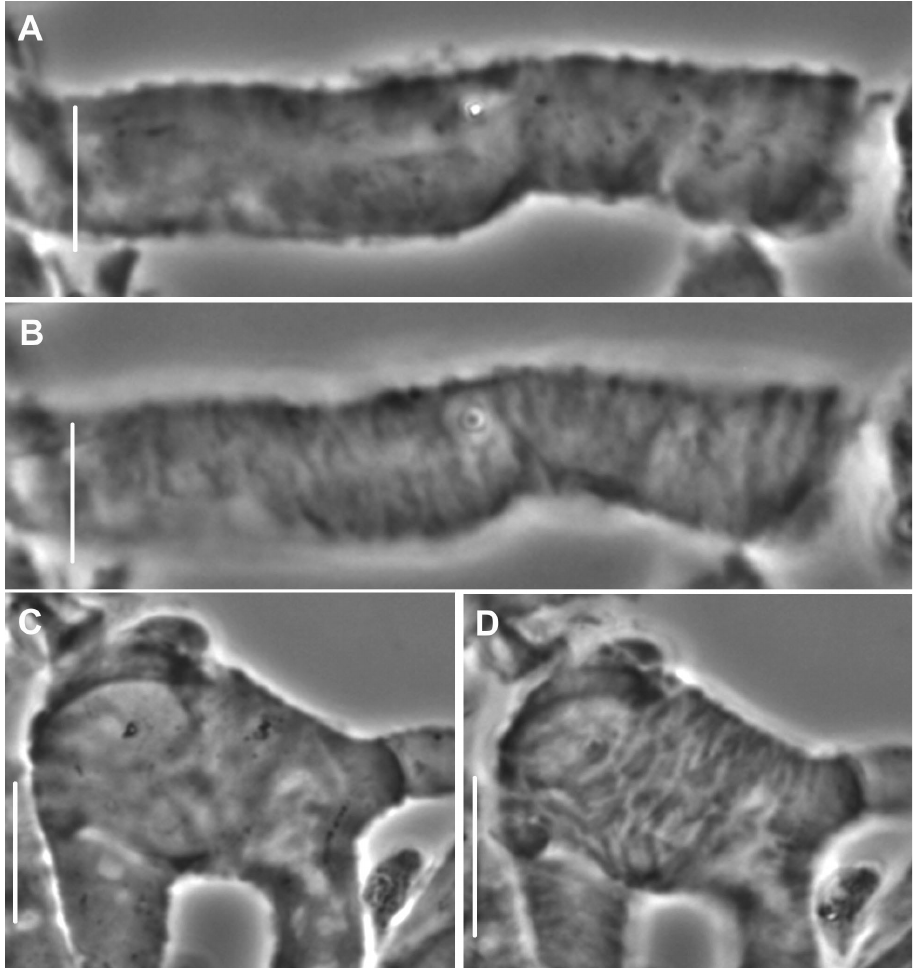
Figure 88. Mycetinis yunnanensis . Pileipellis hyphae. A, C Hyphae seen in profile; note ornamentation appears vague, perhaps spotty B, D Hyphae seen in upper wall surface; note suggestion of annular or striped configuration. Standard bars = 10 µm. TFB 3146